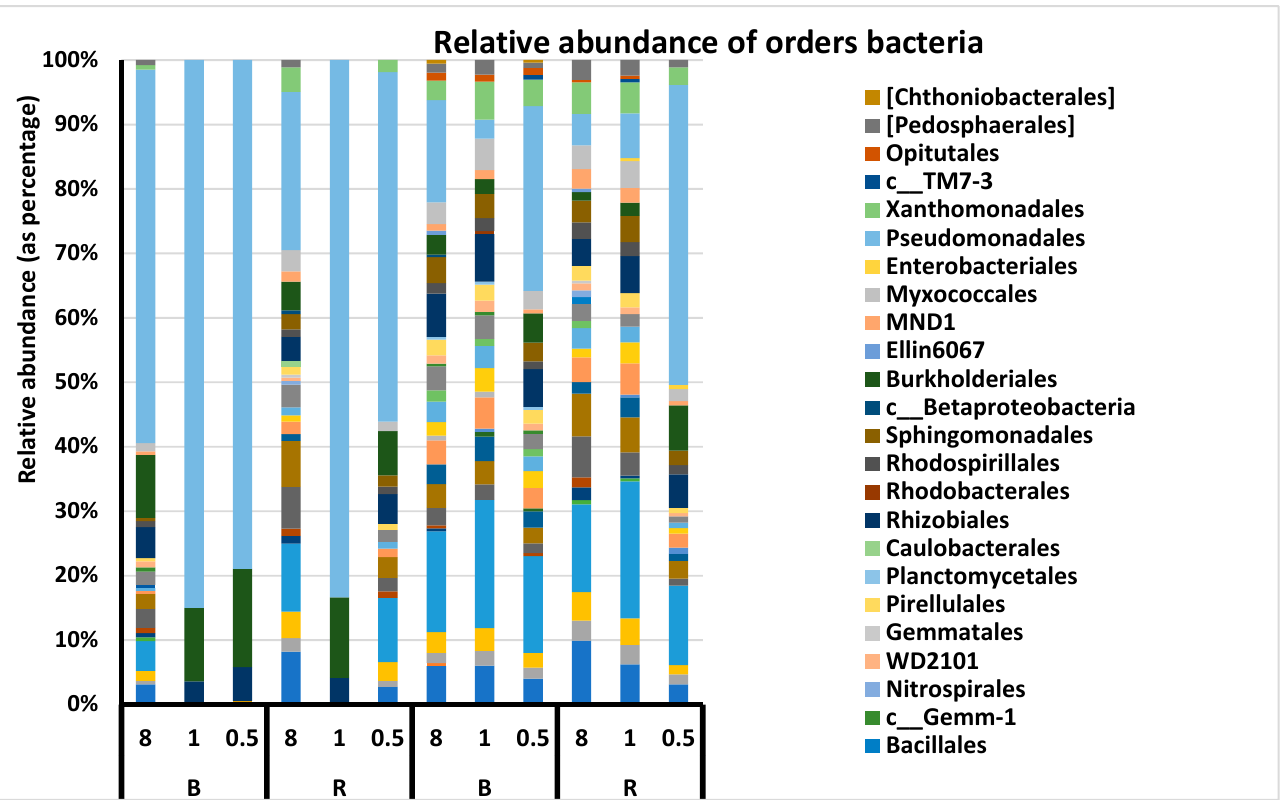
Figure 3. Relative abundance of bacterial orders at different agro-management: organic (Y) and conventional (Ba); at different sampling location: between (B) the plant rows and in the vine rows (R) with different aggregate size (0.5, 1, and 8 mm).